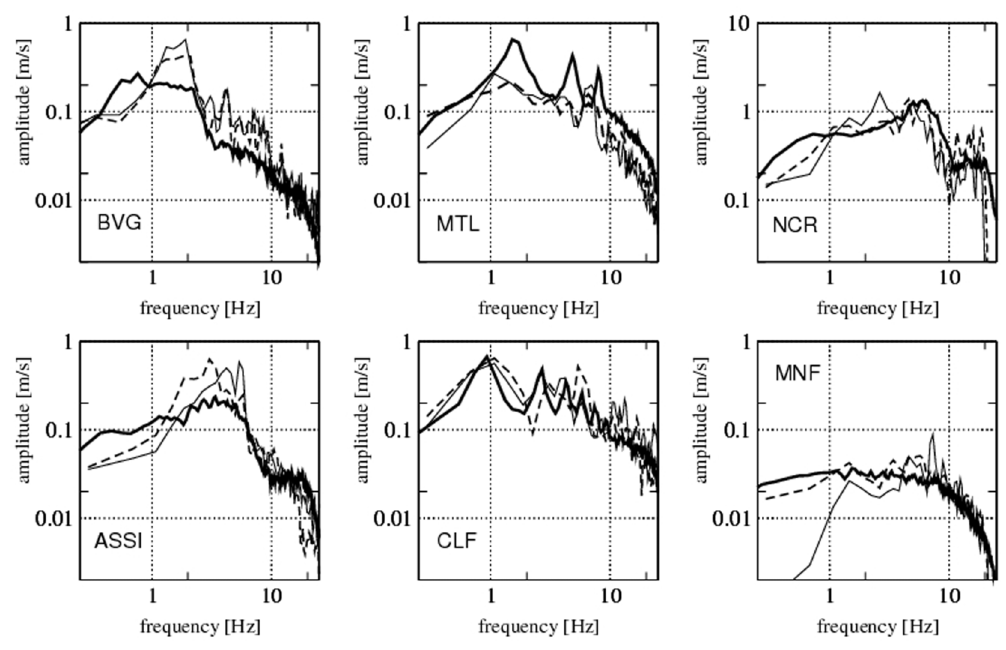
Fig. 8. Comparison of DSM synthetic and observed acceleration spectra at 6 near-source stations. NS and WE horizontal components are plotted with dashed and solid thin lines, respectively. DSM synthetics are plotted with solid thick